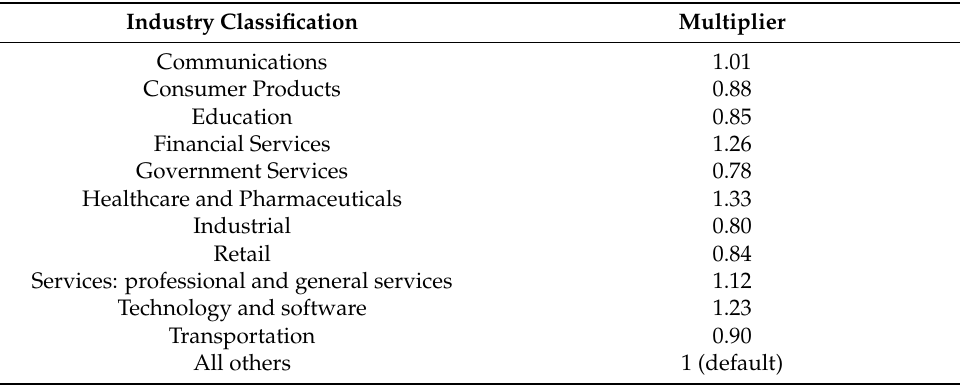
Table 12. Cost factor—organization’s industry classification F I